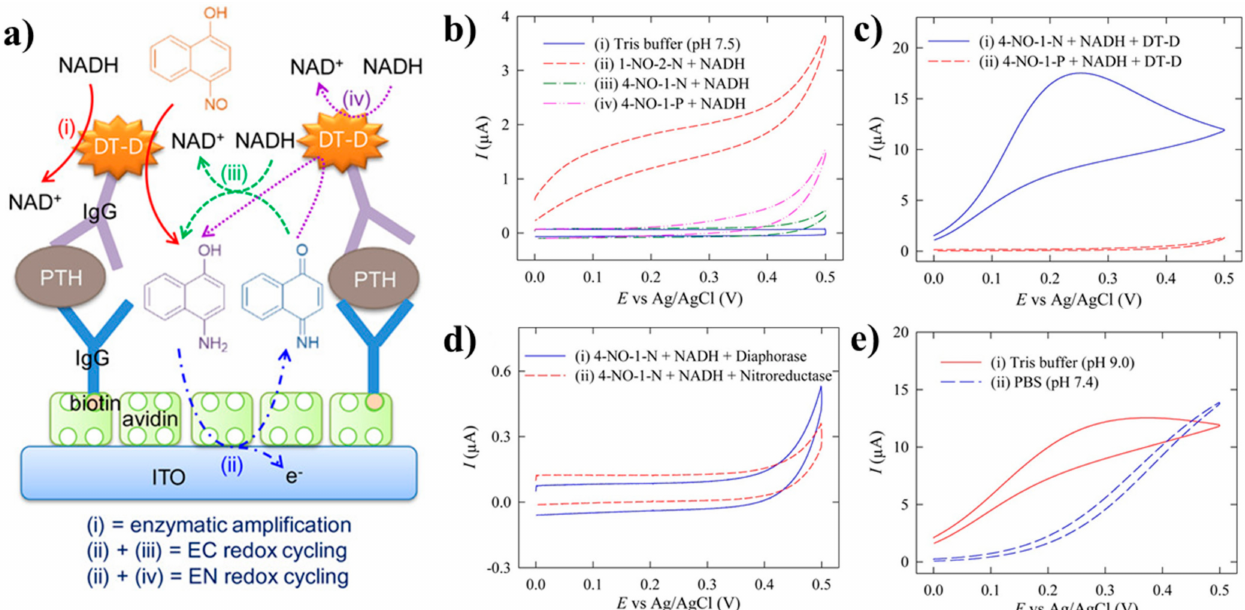
Figure 2. ( a ) Schematics of the electrochemical immunosensor using DT-diaphorase as an enzyme label. ( b ) Cyclic voltammograms (CVs) obtained at the bare indium tin oxide (ITO) electrodes in (i) tris buffer of pH 7.5, (ii) mixture of 1-nitroso-2-naphthol and NADH, (iii) mixture of 4-nitroso-1-naphthol and NADH, (iv) mixture of 4-nitrosophenol and NADH at a scan rate of 20 mV/s after 10 min. incubation period at 25 ◦ C. ( c ) CVs obtained at the bare ITO electrodes in (i) tris buffer of pH 7.5 containing NADH, 4-nitroso-1-naphthol, and DT-diaphorase, (ii) tris buffer of pH 7.5 containing NADH, 4-nitrosophenol, and DT-diaphorase. ( d ) CVs obtained at the bare ITO electrodes in (i) tris buffer of pH 7.5 containing NADH, Diaphorase, and 4-nitroso-1-naphthol, (ii) tris buffer of pH 7.5 containing NADH, nitroreductase, and 4-nitroso-1- naphthol. ( e ) CVs obtained at the bare ITO electrodes in (i) tris buffer of pH 9.0 containing NADH, 4-nitroso-1-naphthol, and DT-diaphorase, and (ii) PBS of pH 7.4 containing 4-nitroso-1-naphthol, NADH, and DT-diaphorase. Reproduced with permission from reference [22]. Copyright © 2020 American Chemical